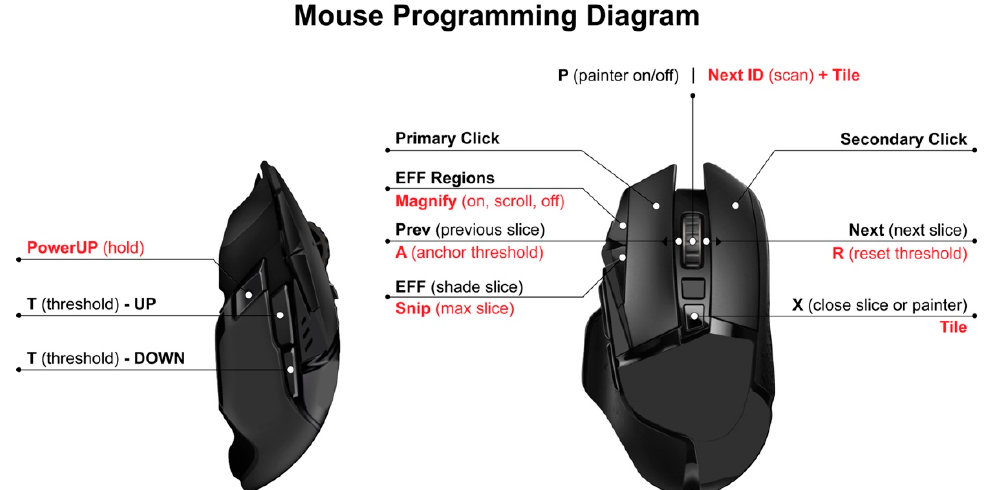
Figure 1. Diagram of mouse displaying 20 software functions programmed as buttons that can be operated rapidly to generate precise e ff usion-synovitis shadings and subregional divisions.